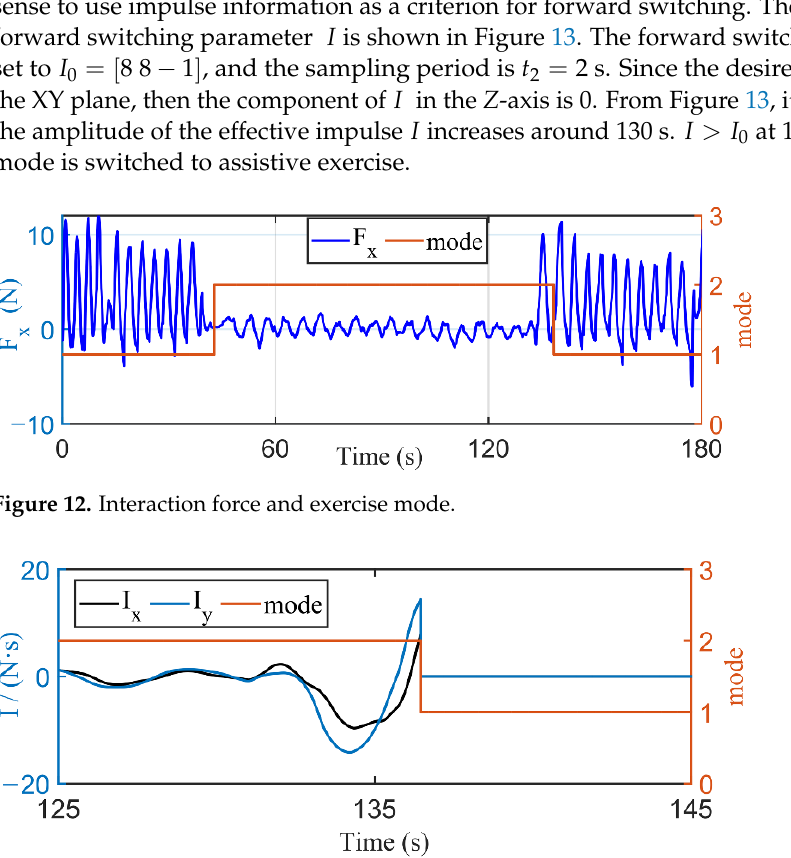
Figure 11. Reverse switching parameter 𝑙.